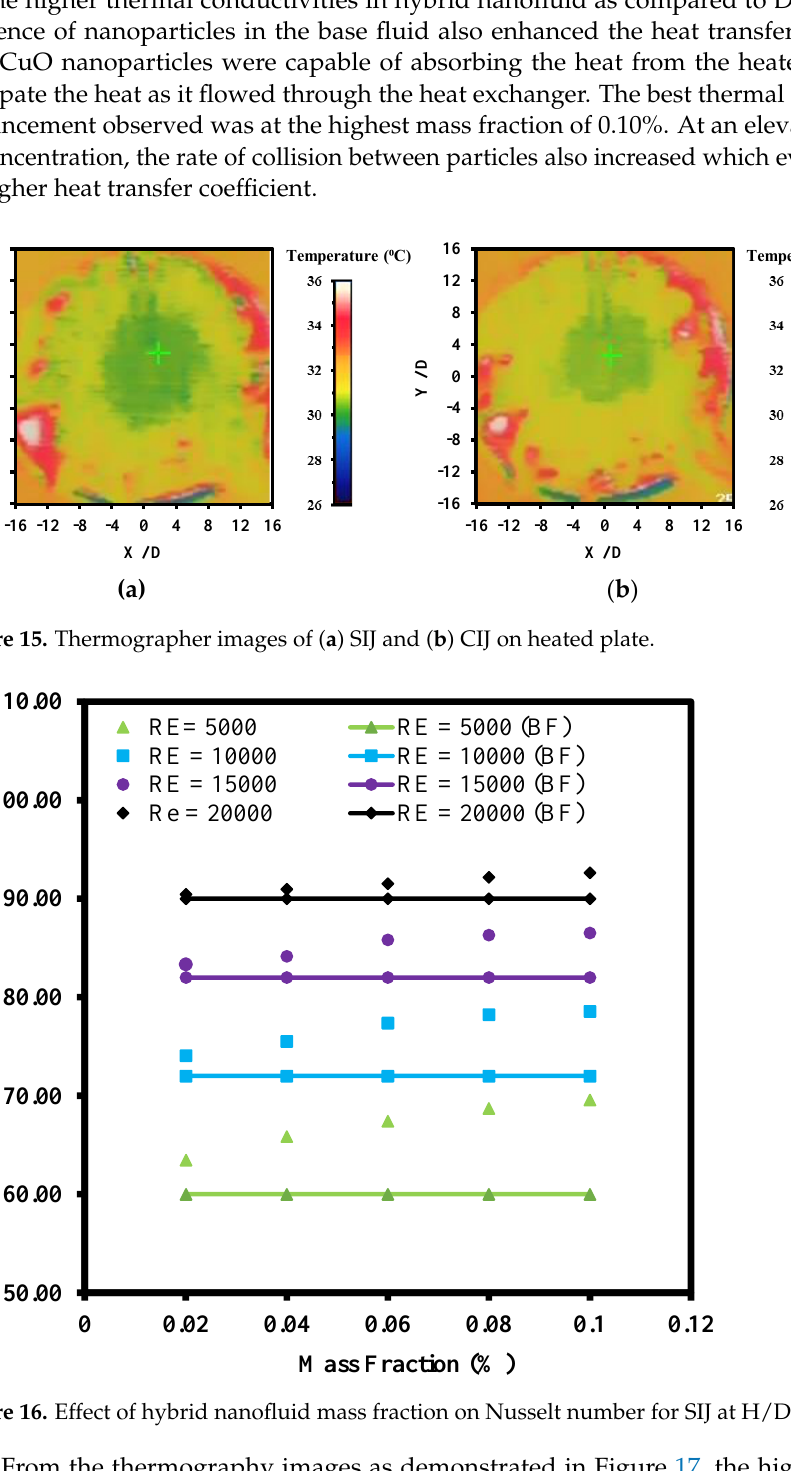
Figure 16. Effect of hybrid nanofluid mass fraction on Nusselt number for SIJ at H/D = 4.